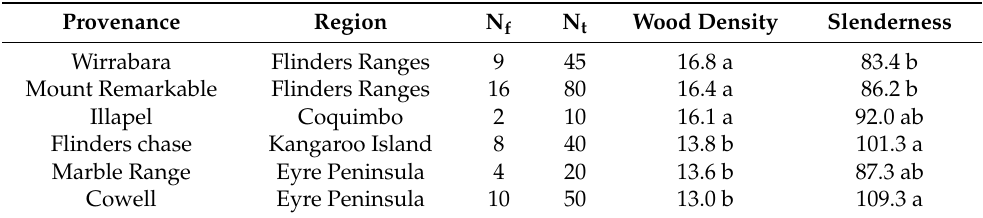
Table 1. Population means for wood density and slenderness coefficient in the populations of E.